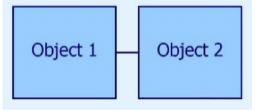
Figure 4. Subtracting objects.